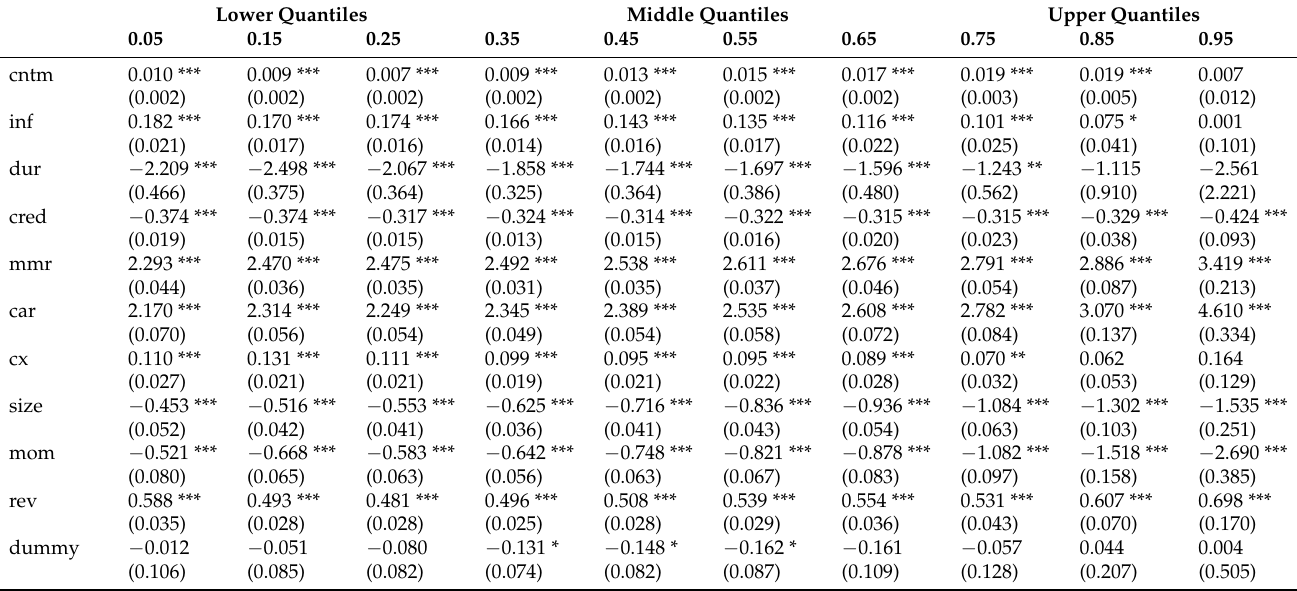
Table 3. Panel Conditional Quantile Regression—Containment and Health